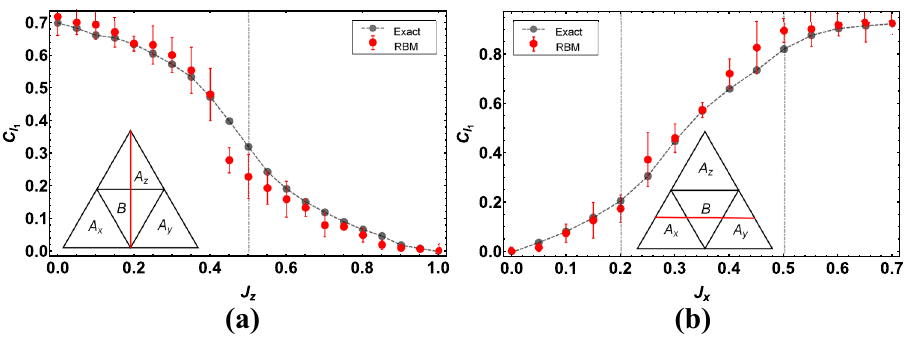
Figure 5. l 1 -norm coherence C l 1 as a function of the coupling strength ( a ) J z with J x = J y = ( 1 − J z )/ 2 , ( b ) J x with J z = 0.3, J y = 0.7 − J x , for a N = 3 × 3 × 2 lattice. Gray vertical lines indicate the critical points. The red solid straight lines indicate the error bars.